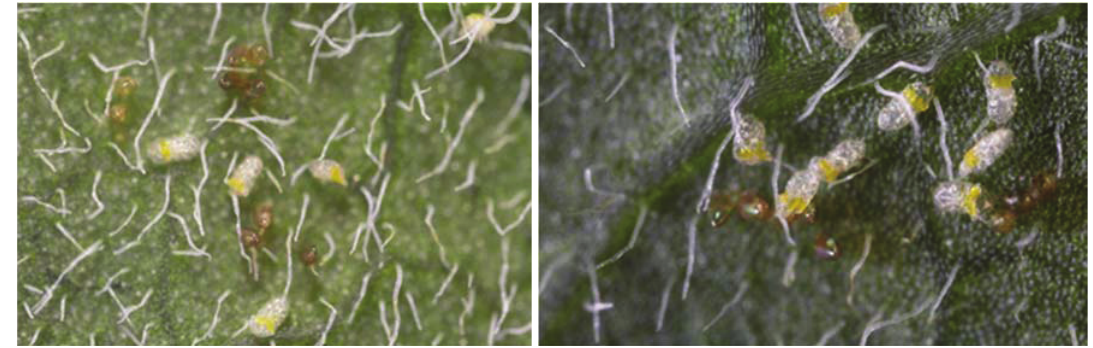
Figure 2. Impact of Tri-Tek on Bemisia tabaci Mediterranean eggs. Some eggs hatched but larvae were detached from leaf surface and subsequently died (Photos: Andrew G. S. Cuthbertson © ).